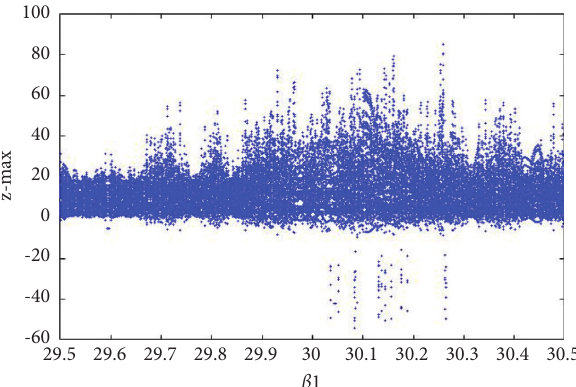
Figure 4: Bifurcation diagram for variation of the parameter β